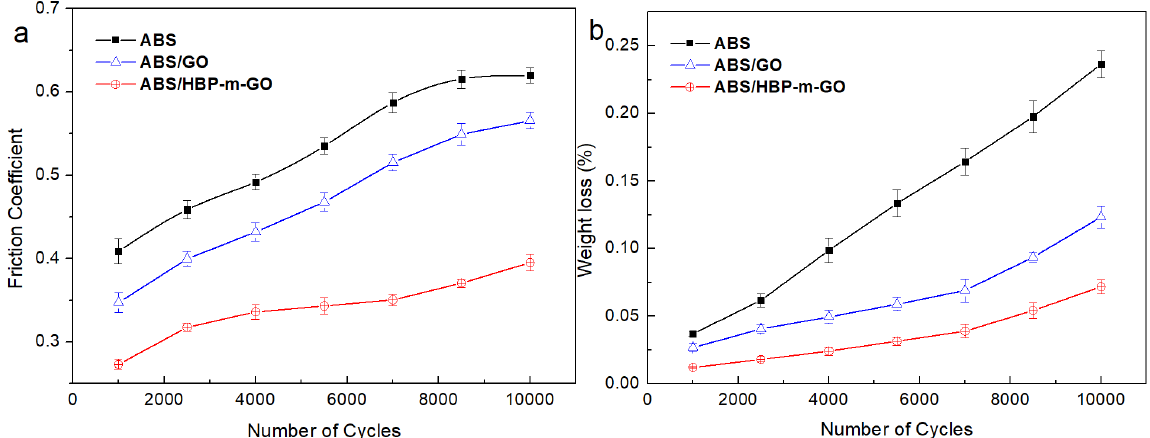
Figure 7. ( a ) Friction coefficient and ( b ) weight losses (%) versus number of sliding cycles for ABS and ABS/GO composites.